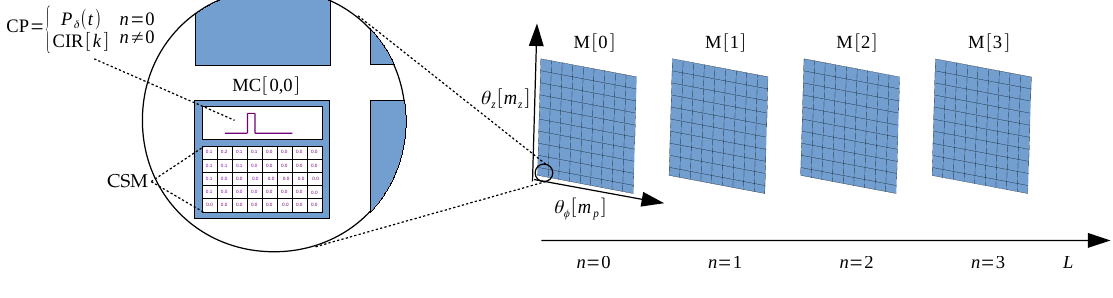
Figure 4. Schematic overview of the